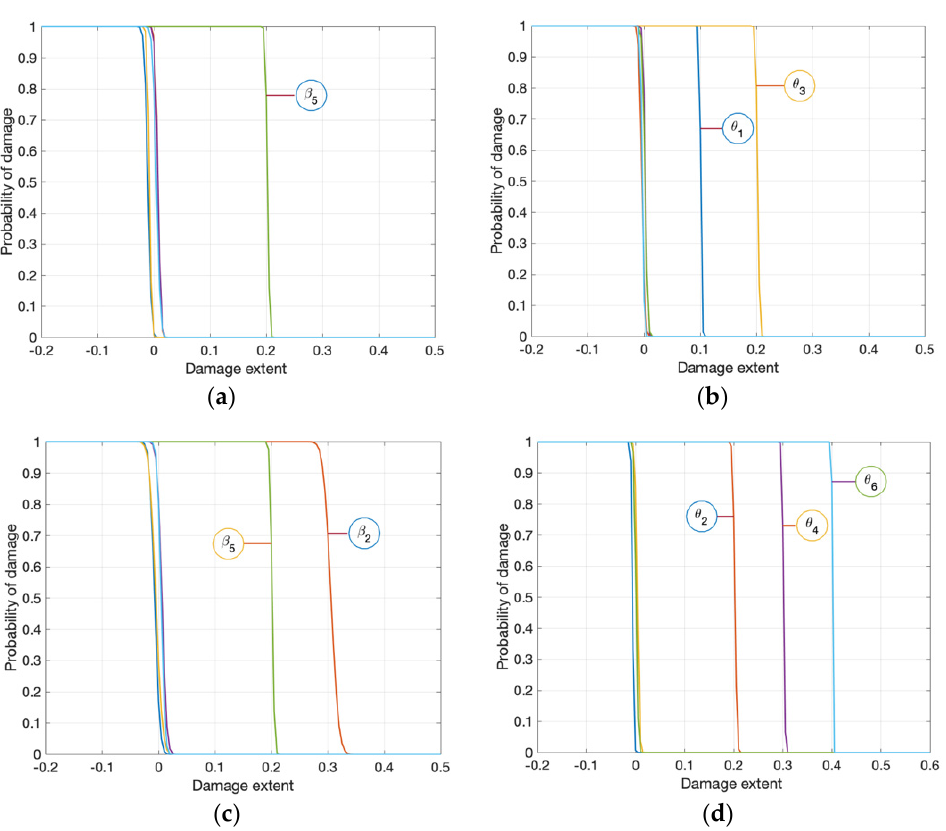
Figure 7. Probabilistic curves. Damage case No. 1: ( a ) mass; ( b ) stiffness. No. 2: ( c ) mass; ( d )